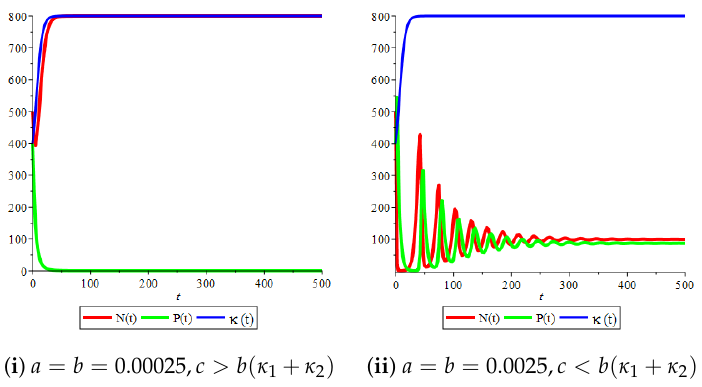
Figure 1. Prey–predator model with Holling type I functional response and logistic carrying capacity, stability of E 4 and E 6 for κ 1 = 300, κ 2 = 500, r = c = 0.25, α =